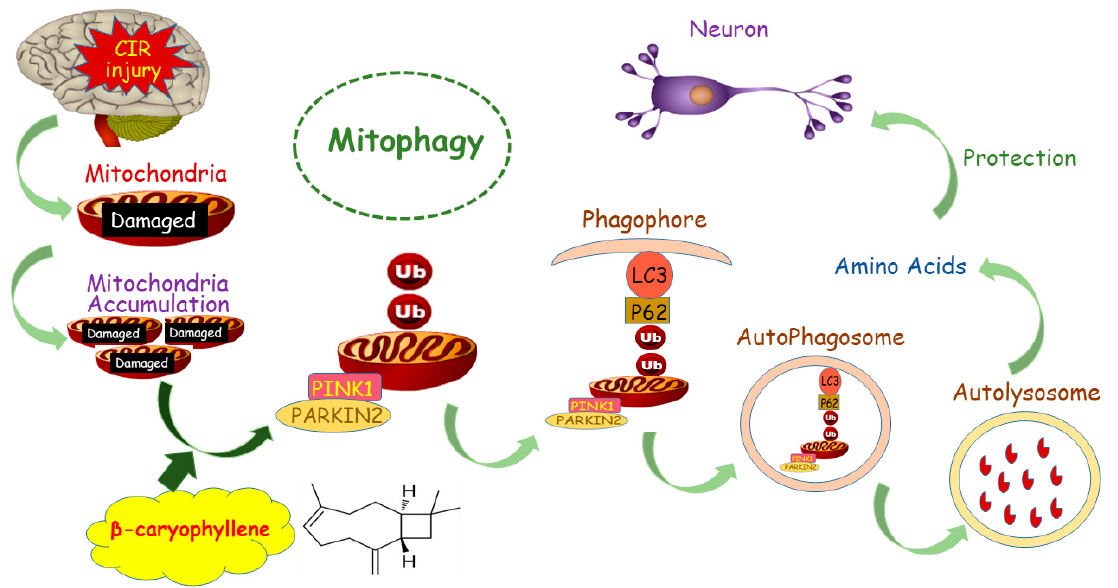
Figure 11. Molecular mechanism of the neuroprotective effect of BCP against CIR-induced neuronal injury. BCP pretreatment could further activate CIR-induced mitophagy to clear damaged mitochondria to reduce brain damage in CIR injury by recruiting Pink1 and Parkin2 on the outer membrane of